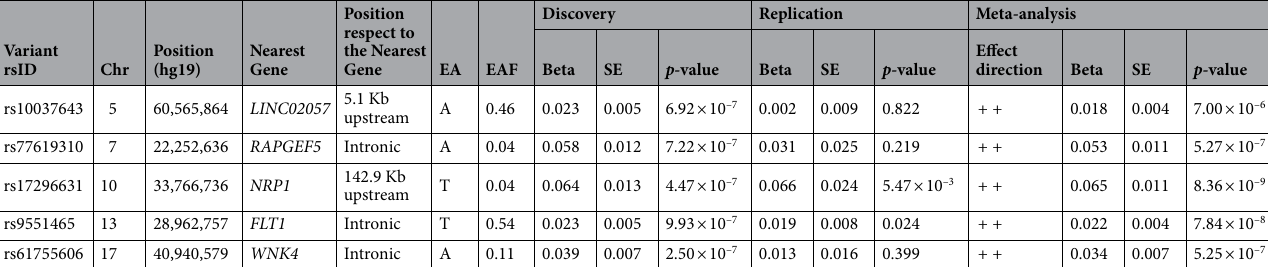
Table 2. Top variant results from discovery and replication meta-analysis. Chr chromosome, EA effect allele, EAF effect allele frequency, SE standard error, Effect Direction: direction of the effect allele on PlGF levels in Discovery and